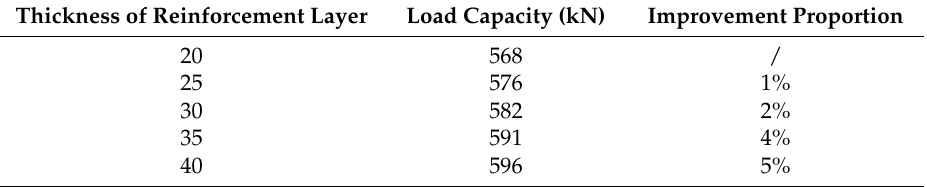
Table 5. Improvement proportion caused by increasing thickness of reinforcement layer.